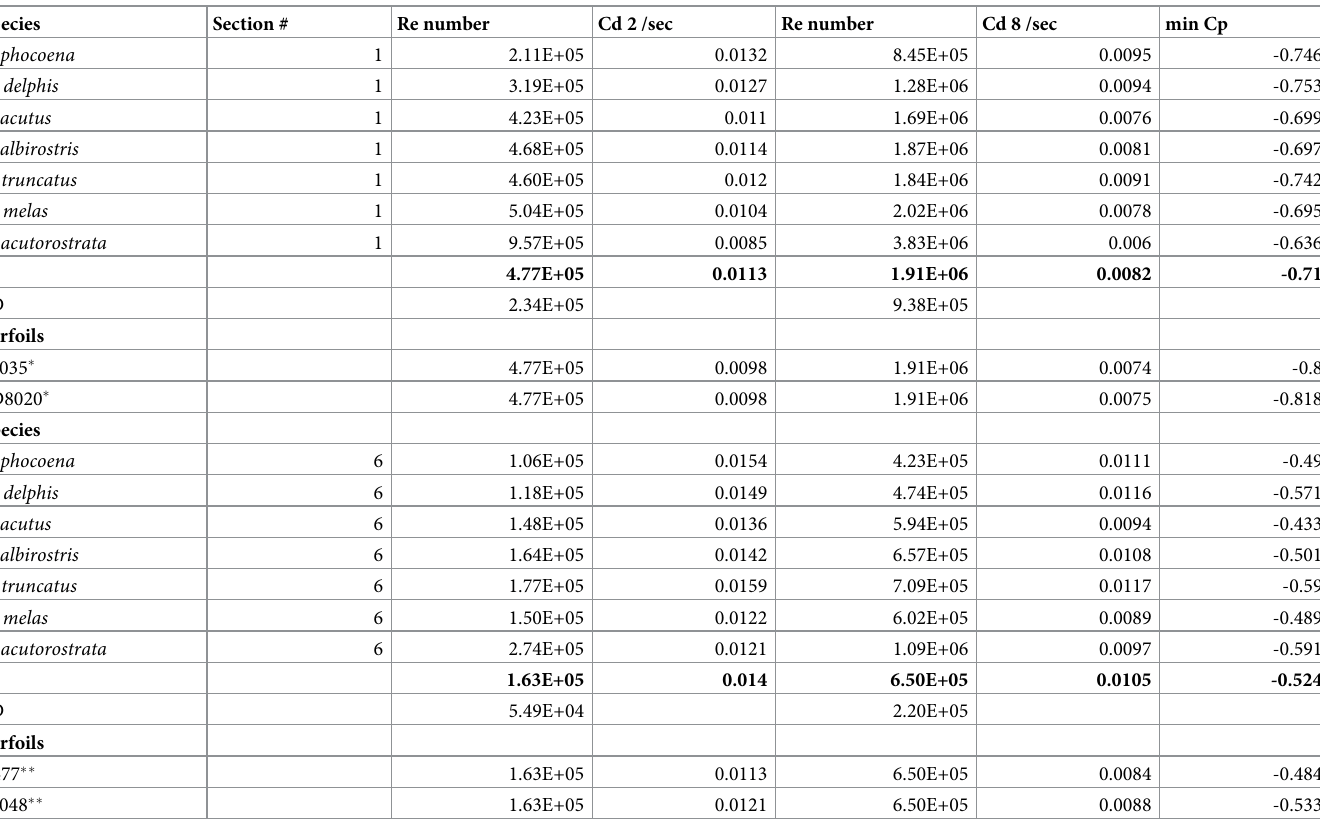
Table 10. Comparison of the hydrodynamic characteristics of the tail fluke cross-sections with the appropriate airfoils.